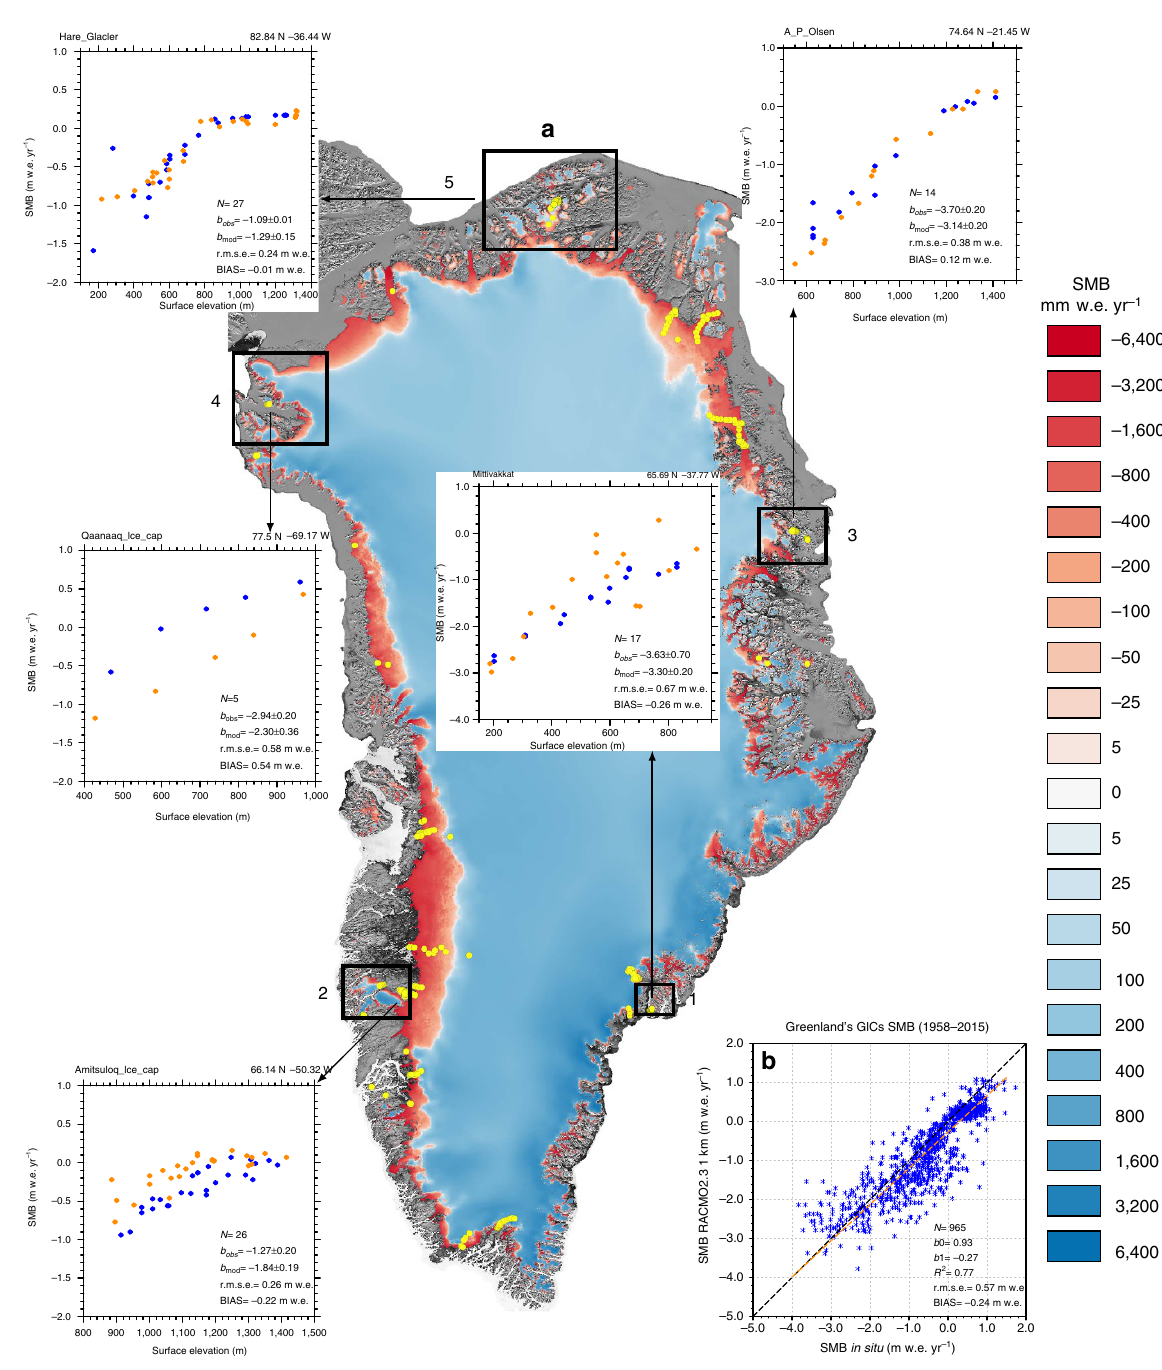
Figure 1 | Greenland SMB patterns and evaluation. ( a ) Annual mean downscaled SMB (v1.0, see Methods) at 1km resolution over the GrIS and neighbouring GICs for 1958–2015. Yellow dots correspond to 331 SMB observation sites used for GrIS (230) and GICs (101) evaluation. Numbered black boxes depict five regions including stake transects collected over GICs. For each transect, annual mean SMB is plotted from downscaled simulation v1.0 ( b mod ; dark blue dots) and in situ data ( b obs ; orange dots). The number of observations, observed and downscaled SMB gradients, r.m.s.e. and mean BIAS are also listed for each transect. ( b ) Comparison of ablation measurements collected at 101 GICs sites with downscaled SMB at 1km (v1.0). The orange dashed line represents the regression including all measurements ( y ¼ b 1 þ b 0 (cid:3) x